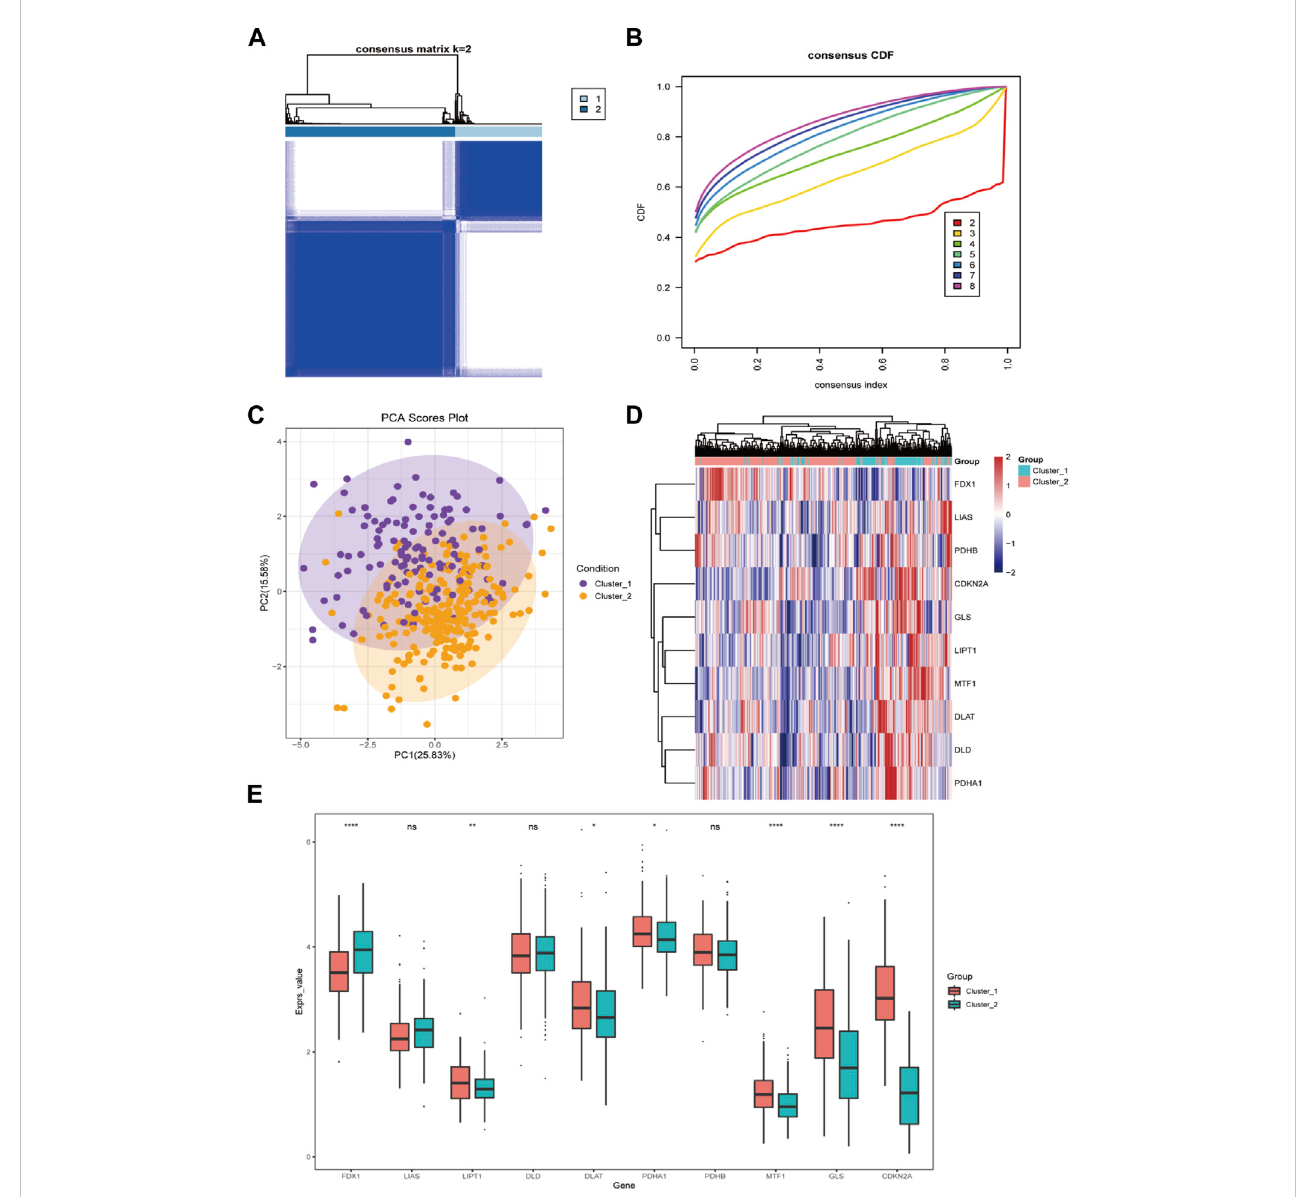
FIGURE 3 The cuproptosis-related genes divide hepatocellular carcinoma into two subtypes. (A) The sample squareness of the consistent clustering (number of classi fi cations = 2); (B) The cumulative distribution map of the consistent clustering; (C) The principal component analysis graph of the two hepatocellular carcinoma subtypes; (D) The cuproptosis-related genes in the two categories Expression heatmap of hepatocellular carcinoma; (E) Boxplot of cuproptosis- related genes expression difference between twotypes of hepatocellularcarcinoma(ns: p > 0.05; *: p < 0.05; **: p < 0.01; ***: p < 0.001; ****: p <